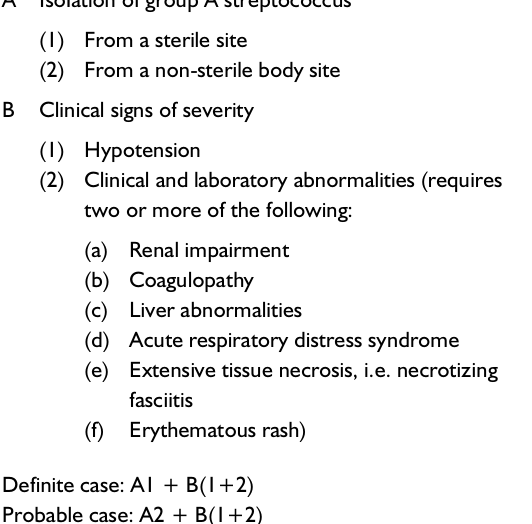
Table 2 Streptococcal toxic shock syndrome is defined as any group A streptococcal infection associated with the early onset of shock and organ failure